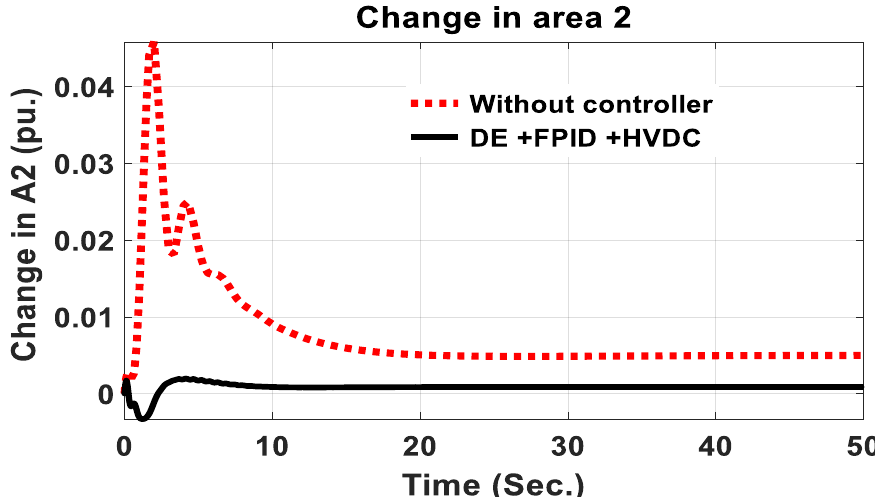
Figure 8. Comparison of controller and without controller for change in ACE 1.